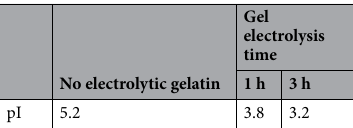
Table 2. pI of the Gel electrolyte for the anode area with an anionic membrane.